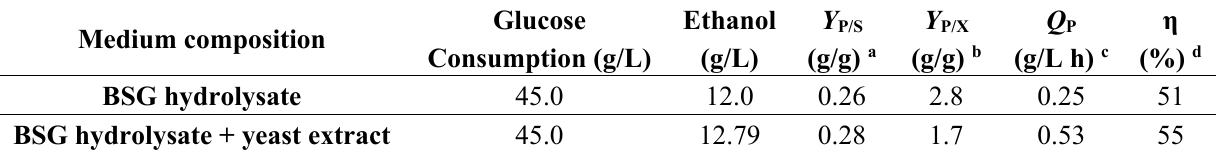
Table 4. Fermentative parameters of ethanol production by Saccharomyces cerevisiae NRRL YB 2293 from BSG hydrolysate and BSG hydrolysate + yeast extract. Medium